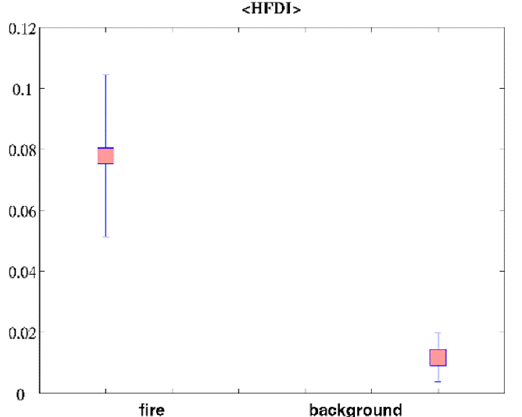
Figure 8. Separability of Ben Halls Gap National Park fire indices HFDI mean value over the twenty-four combinations is 0.0778 ± 0.0265, and the background is 0.0117 ± 0.0080. Finally, we calculated the potassium emission index by using the PRISMA band 44, centered at 770.25 nm (for the emission, Figure 9a) and the band 45 centered at 780.63 nm (for the background). The scatter plot obtained for the two bands shows a high correlation between the bands (Figure 9b). The results for the two indices are shown in Figure 9c,d. We can observe the prevalence of the striping effect over the signal. The fire is not recognizable when using the band ratio, and it is blurred and difficult to delineate when using the AKBD metric.